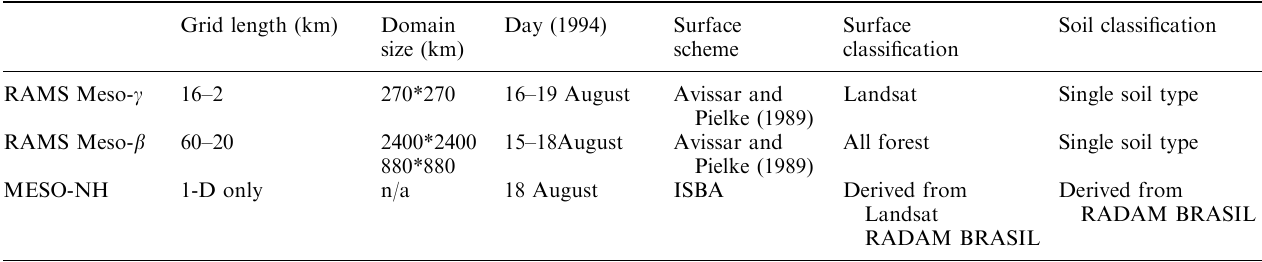
Table 1. Characteristics and main di(cid:128)erences between the models Grid length